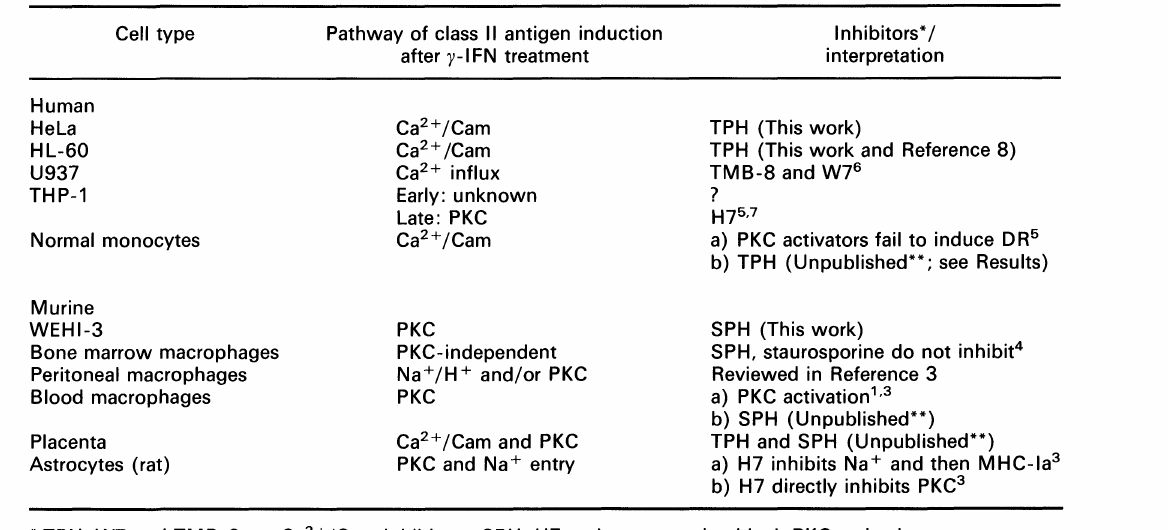
Table 2. Summary of signal transduction pathways followed by -IFN in up-regulating class II antigen expression in human and mouse